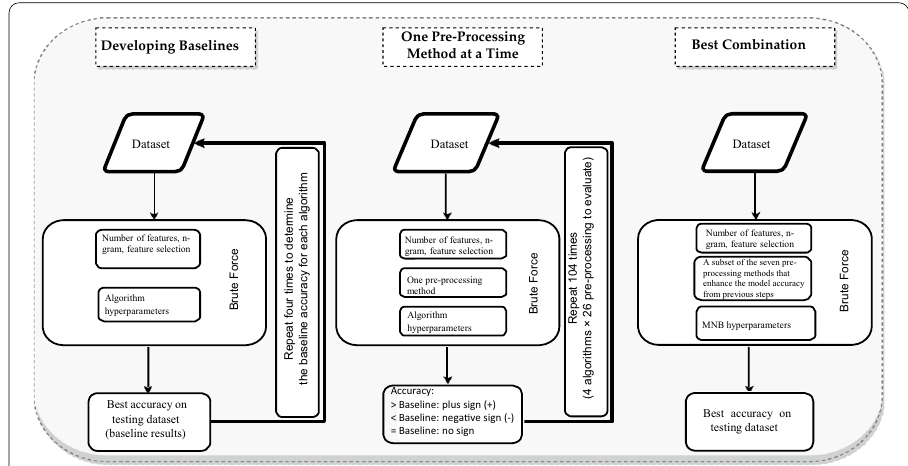
Fig. 2 Overview flowchart for the first experiment. (In the best combination, we only tried MNB as it was the best algorithm from previous